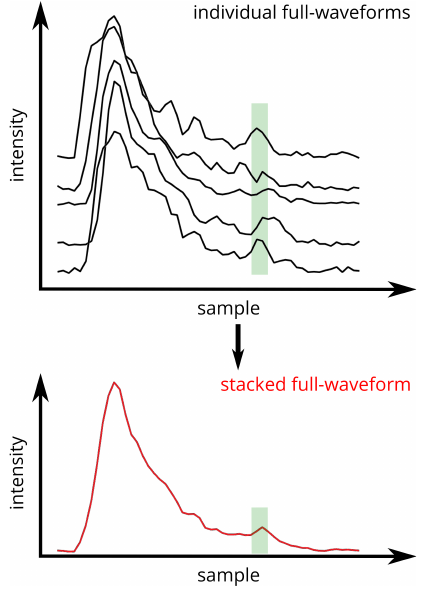
Figure 5. Principle of waveform